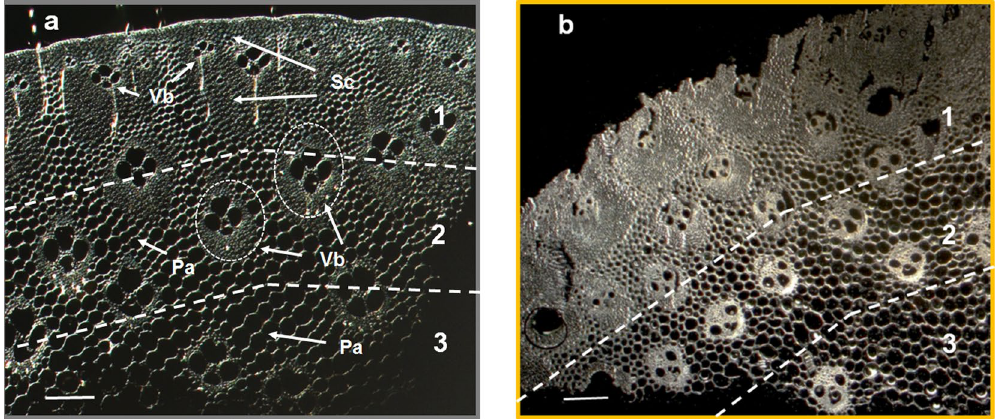
Figure 1. Visible light imaging of stem tissue architecture of untreated and chlorite-treated miscanthus sections. ( a ) Untreated miscanthus. ( b ) Chlorite-treated miscanthus. For each sample, transverse sections show three main regions: 1) rind with thick layer of sclerenchyma (Sc) and small vascular bundles (Vb), 2) middle region rich in interfascicular parenchyma (Pa) and vascular bundles which are surrounded by a wide sclerenchyma sheath, 3) innermost region rich in parenchyma. Scale bar is 200 µ